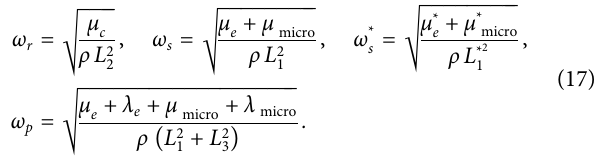
Frontiers in Materials |